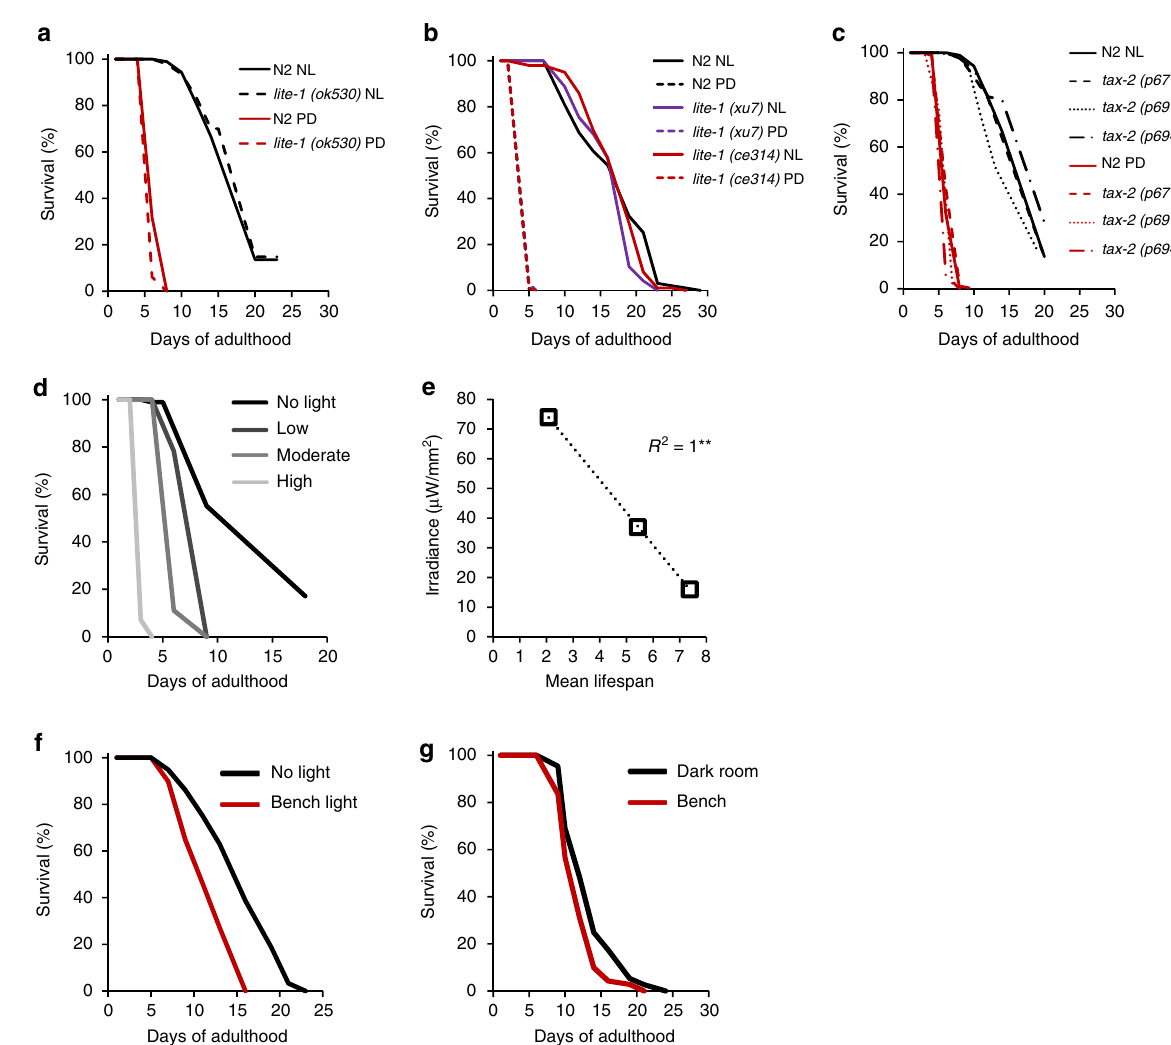
Fig. 3 Light intensity is the primary signal decreasing the lifespan. a Lifespan of lite-1(ok530) mutants and b lite-1(xu7) and lite-1(ce314) under PD or NL conditions. c Lifespan of tax-2 mutants is reduced upon daily light exposure. d Lifespan of N2 worms is proportional to the intensity of white light received (permanent-day condition). e Relationship between light intensity and mean lifespan; the black dotted line represents a linear trendline of the series. f Lifespan of worms exposed to laboratory light versus worms kept in the dark. g Lifespan of worms scored and transferred in the dark under dim stereomicroscope light, versus worms scored and transferred under laboratory light. ** P < 0.01 using Pearson ’ s coef fi